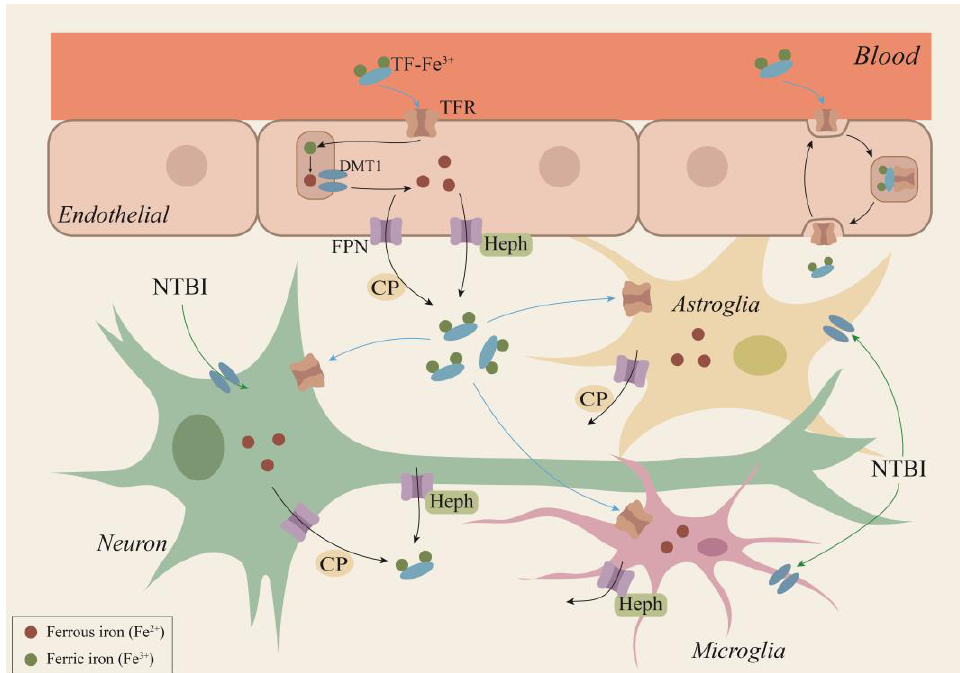
Figure 2. A hypothetical scheme for iron transport within the brain. Circulating plasma iron access the brain by traversing the BBB. Iron transport across the endothelial barrier can be partitioned into two possible mechanisms. The first is the transcytosis model, where the TF receptor complex is transported into endosomes across the BMVEC cytosol and is directly released into the brain at the abluminal membrane of BMVECs. The second is the classical pathway, where iron enters endothelial cells by binding to TFR1 receptors, then is released from TF in endosomes following the acidification of this compartment, and finally iron is transferred out of endothelial cells through FPN. Neurons, astrocytes, and microglia can take up TF-Fe by TFR1/DMT1 or NTBI via a DMT1-dependent pathway. Iron efflux from the neuron is mediated by FPN/CP and/or FPN/Heph pathways, from astrocytes by FPN/CP, and from microglia by the FPN/Heph route. BBB: blood – brain barrier; BMVECs: brain microvascular endothelial cells; CP: ceruloplasmin; TF: transferrin; TFR1: transferrin receptor 1; DMT1: divalent metal transporter 1; FPN: ferroportin; NTBI: non-TF-bound iron form; Heph: hephaestin.